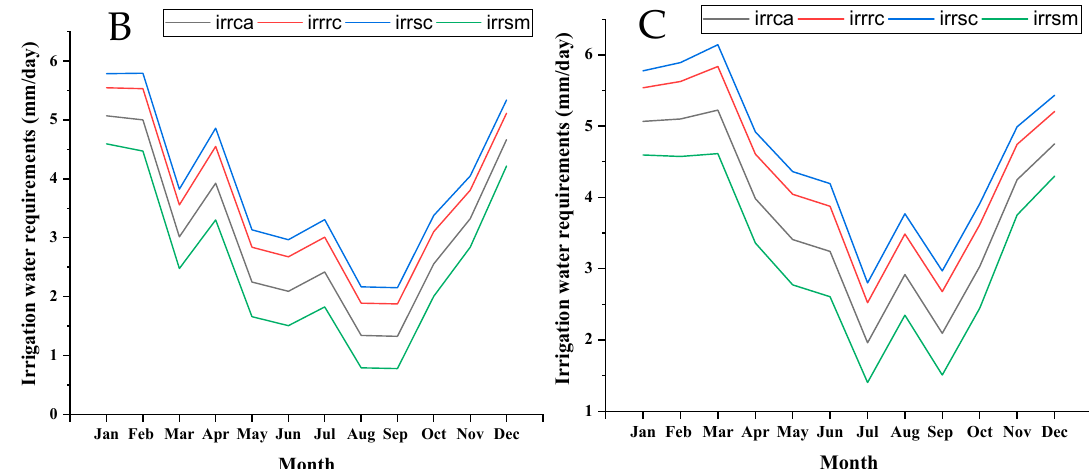
Figure 11. Evolution of IWR (in mm/day) under MIROC 5 RCP 4.5. ( A ) Demonstrates annual irrigation water requirements. ( B ) Demonstrates monthly irrigation water requirements for 2023, which have the lowest irrigation water requirements by crops. ( C ) Demonstrates = monthly irrigation water requirements for 2043 with the highest irrigation water requirements by crops. Same as Figure 3.